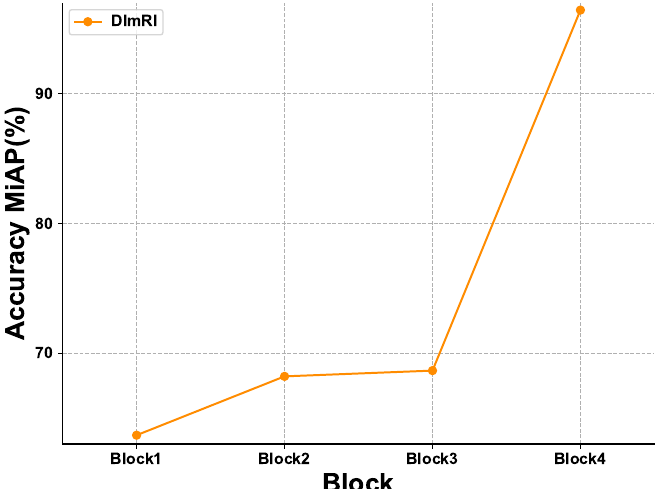
Figure 11. The figure shows the effect of imposing a margin on different blocks on the MiAP score using our DlmRl.